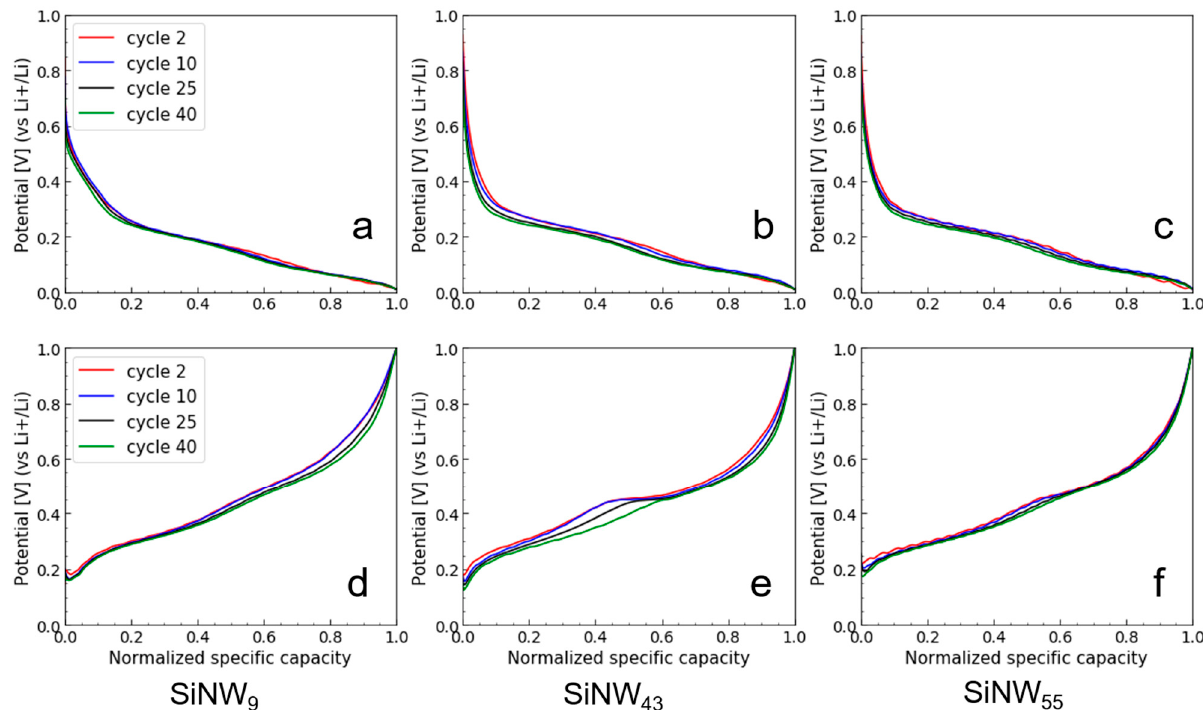
Figure 8. Normalized galvanostatic curves in lithiation ( a – c ) and delithiation ( d – f ) as a function of the cycle numbers for SiNW 9 ( a , d ), SiNW 42 ( b , e ), and SiNW 55 ( c , f ).